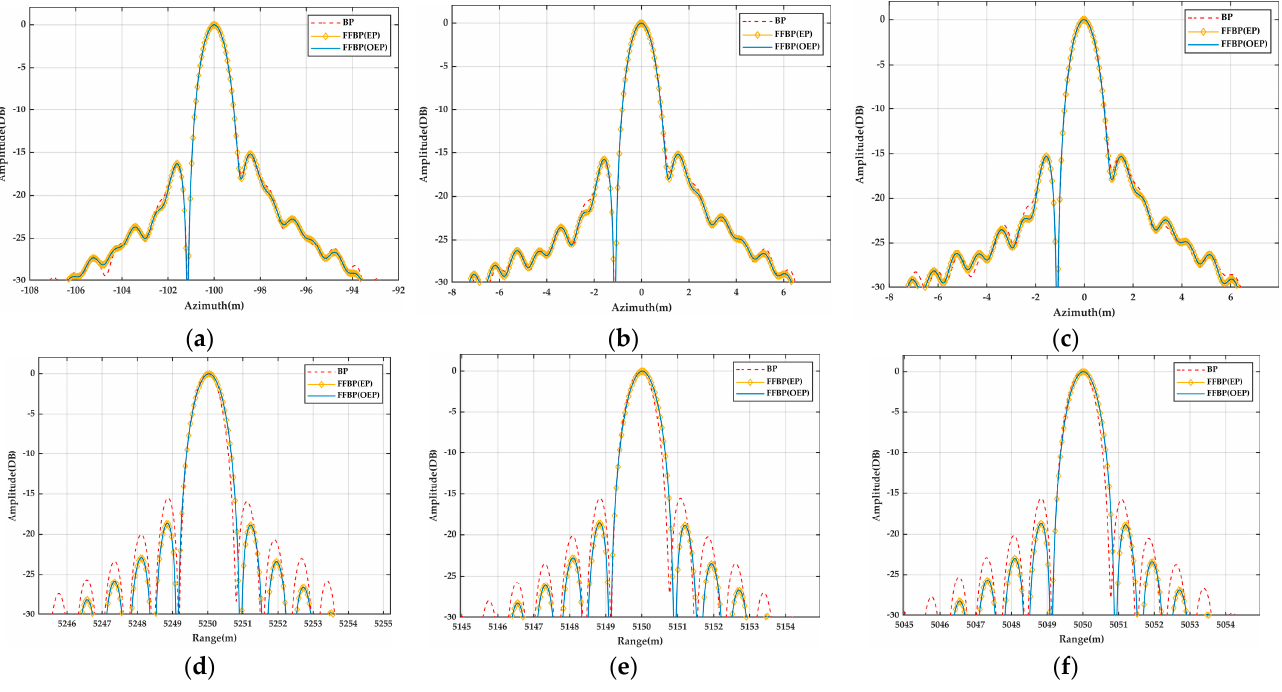
( i ) Figure 11. The counter plots of the impulse response of the selected point targets. ( a ) The target A focused by the bistatic BP algorithm; ( b ) The target A focused by the bistatic EP FFBP algorithm; ( c ) The target A focused by the proposed bistatic FFBP algorithm; ( d ) The target B focused by the bi- static BP algorithm; ( e ) The target B focused by the bistatic EP FFBP algorithm; ( f ) The target B focused by the proposed bistatic FFBP algorithm; ( g ) The target C focused by the bistatic BP algo- rithm; ( h ) The target C focused by the bistatic EP FFBP algorithm; ( i ) The target C focused by the proposed bistatic FFBP algorithm. To further compare the e ff ectiveness of the proposed bistatic FFBP algorithm, the range and azimuthal pro fi le analysis has been conducted on the contour maps of the im- aging results for the selected point targets, as shown in Figure 12. The range of the pro fi les is [ − 30, 0] dB, the red dashed line represents the bistatic BP imaging results, the yellow